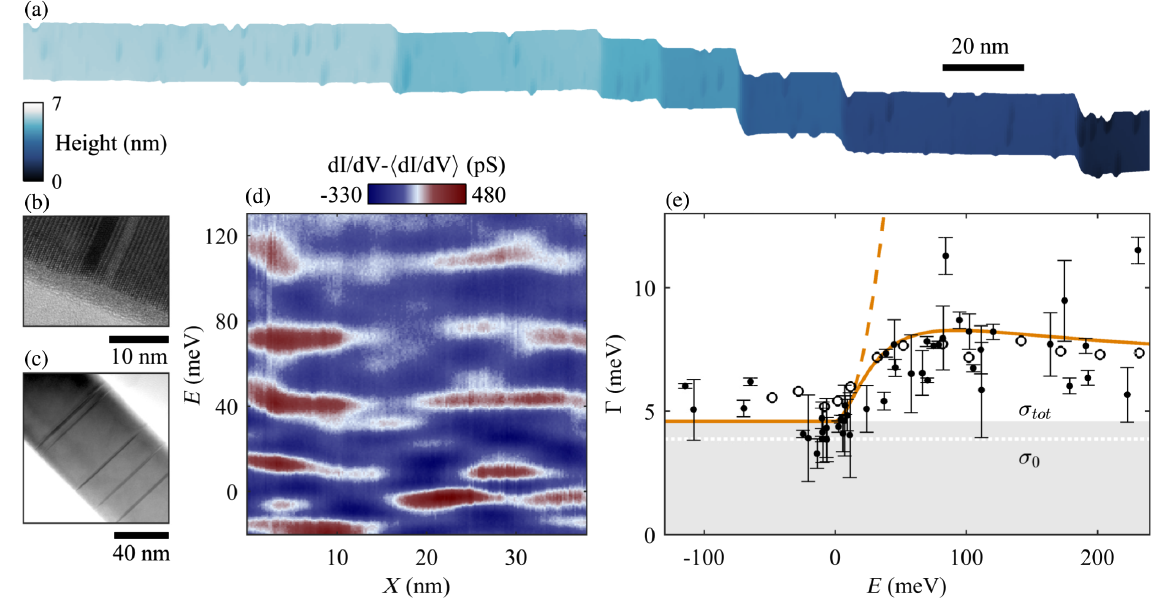
FIG. 3. Nonmonotonic phase coherence time extracted from Fabry-Pèrot resonators. (a) Topographic image showing a series of adjacent stacking faults on the top facet of the nanowire. (b) High-resolution TEM micrograph demonstrating that a single stacking fault induces atomic displacement. (c) TEM micrograph of a nanowire from the same growth batch showing a similar distribution of stacking faults. (d) Typical dI/dV line cut along a terrace terminated by adjacent stacking faults (mean spectrum subtracted) showing quantized resonances. Up to 20% of the mean LDOS is modulated. (e) Energy broadening of the quantized resonances Γ ð E Þ as a function of their energy (black dots). The error bars originate in a two-stage fitting procedure described in Appendix E 2. At the Fermi energy, the broadening σ is attributed to instrumental contributions of temperature and probing ac amplitude, σ 0 ¼ 3 . 9 meV (up to the dotted line) tot and the transmissivity of the stacking faults, about 1.1 meV, setting a lower bound on the reflection coefficient of j R j 2 ≥ 0 . 8 (cid:2) 0 . 1 . The excess energy-dependent broadening (above σ ) is attributed to the finite coherence time of the electrons τ φ . Both the model (solid line) tot and the coherence length data from Fig. 2(c) (circles) agree on the nonmonotonic evolution of the electronic phase coherence and deviate from the low-energy evolution (dashed